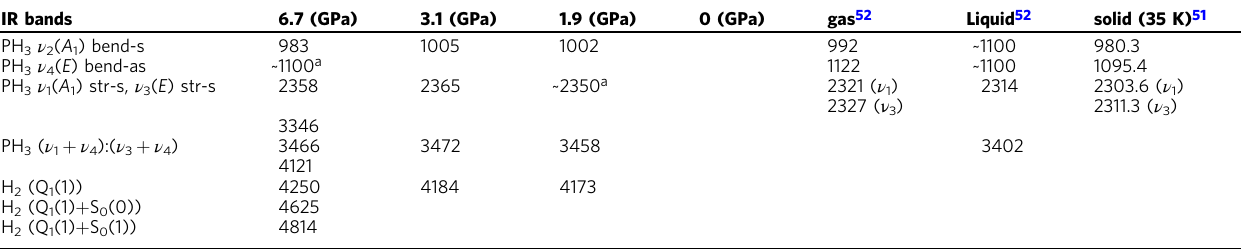
Table 1 Infrared absorption frequencies at different pressure